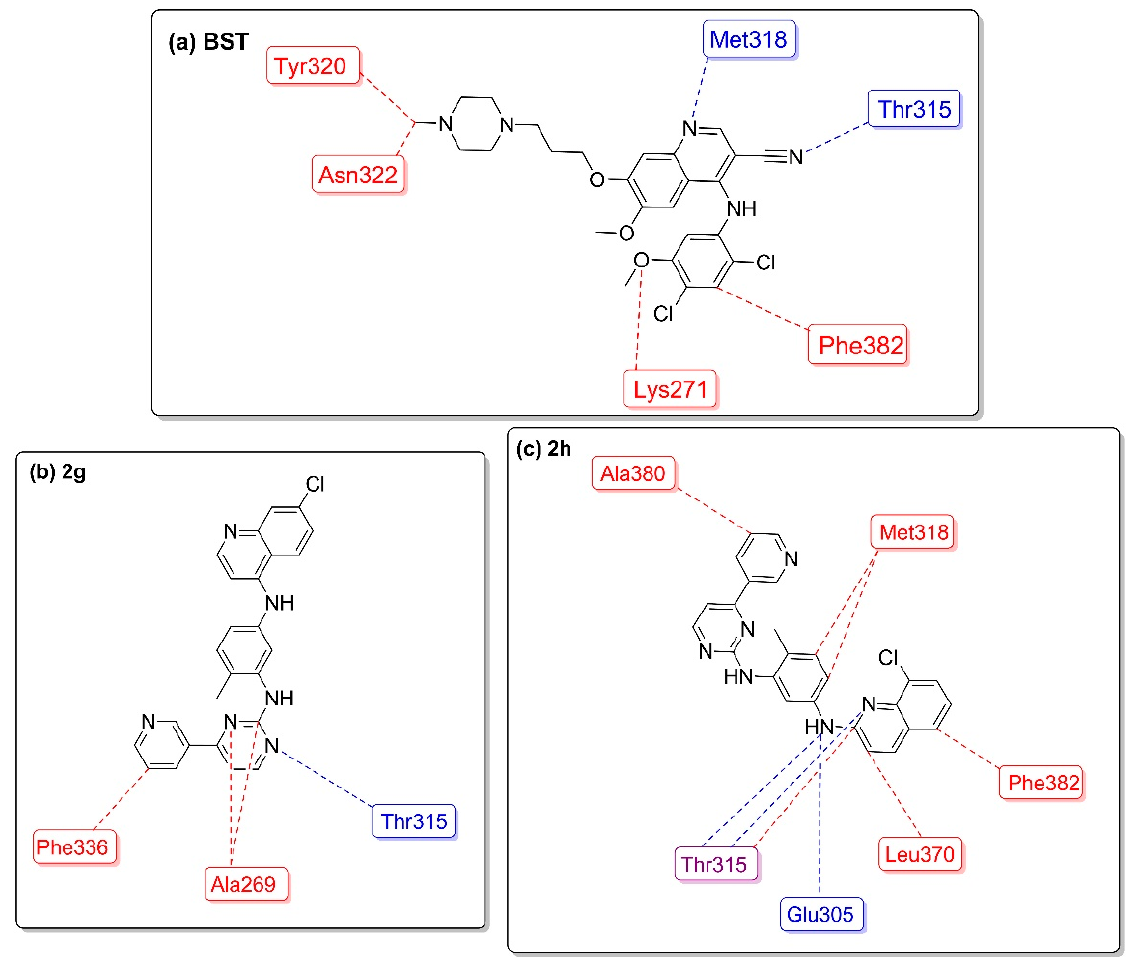
Figure 8. Interaction maps of inhibitors BST ( a ), 2g ( b ), and 2h ( c ) with the BCR-ABL1 structure (PDB code: 3UE4), showing steric interactions (red dotted lines) and hydrogen bonds (blue dotted lines).